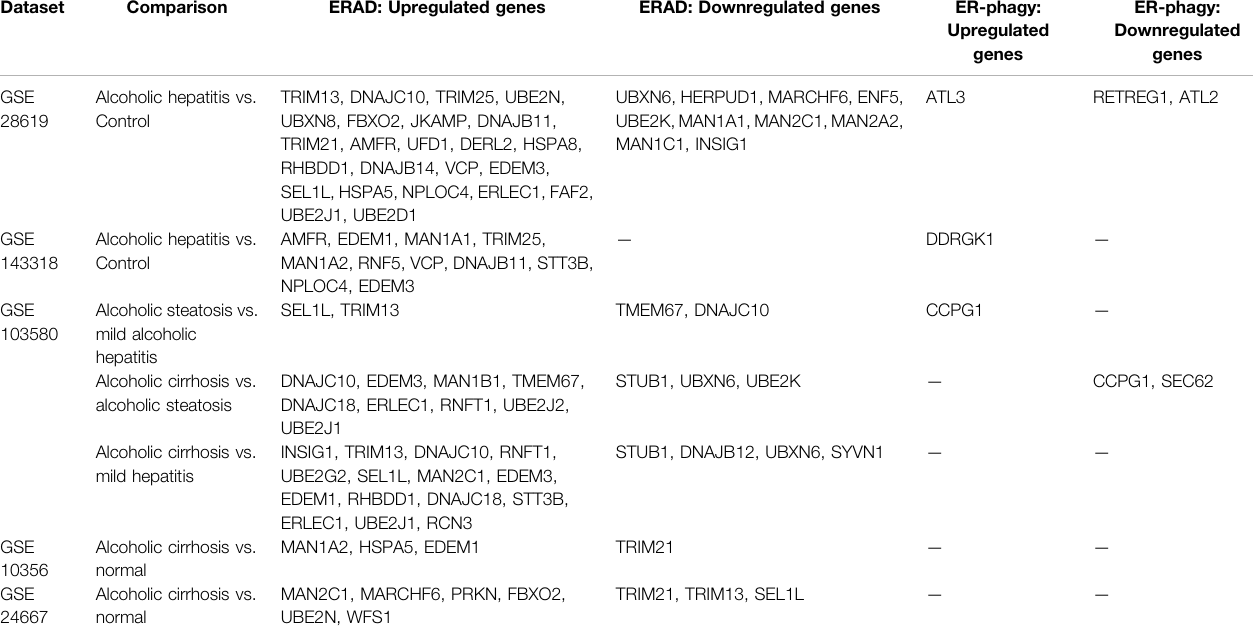
TABLE 2 | RNAseq analyses from patients with Alcohol-related liver disease.